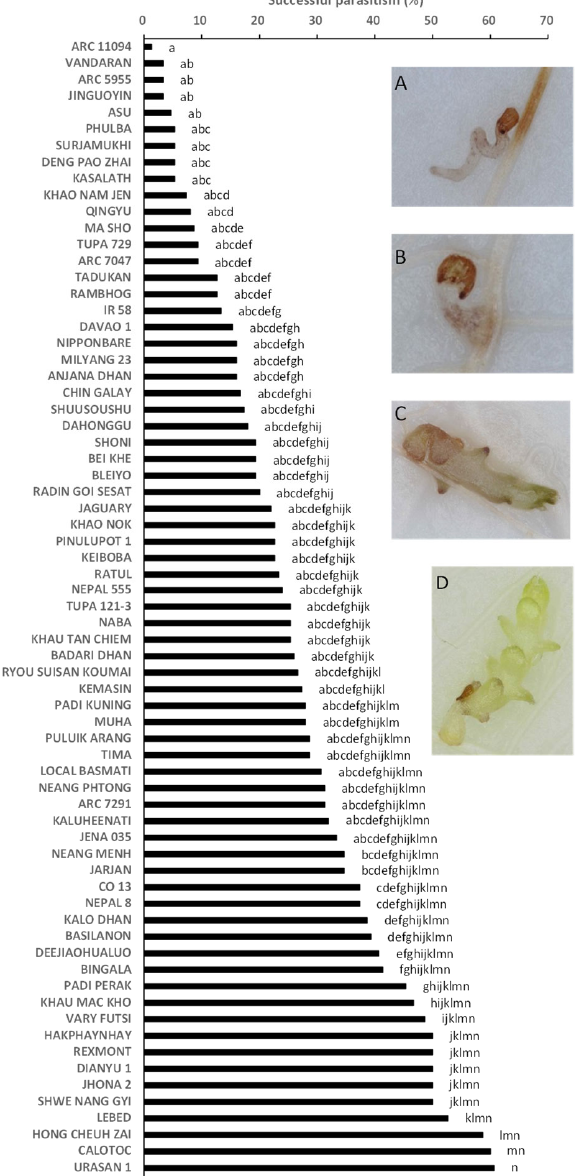
Figure 3. Percentage of successful parasitism out of 30 seedlings of S. hermonthica (post-attachment resistance) on the root of 69 accessions in World Rice Core Collection. Means followed by a common letter are not significantly different by Tukey’s HSD test ( p < 0.05). Insert A , B , C is unsuccessful parasitism because of failure to attach, no shoot emergence, and withering, respectively. Insert D is successful